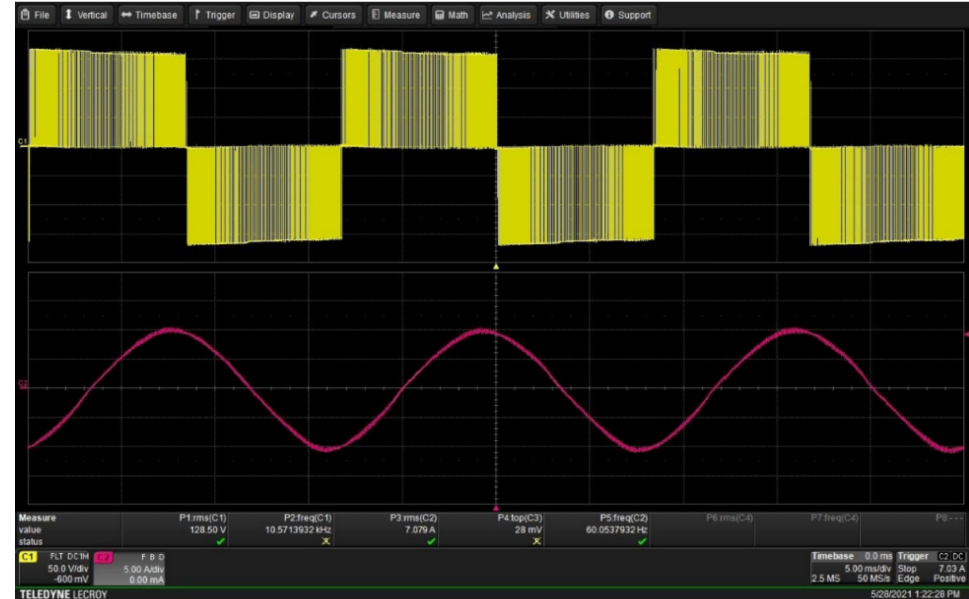
Figure 15. Experimental results of voltage and current at the output of the modular single-phase VSI, steady state (50 V/div, 5 A/div, 5